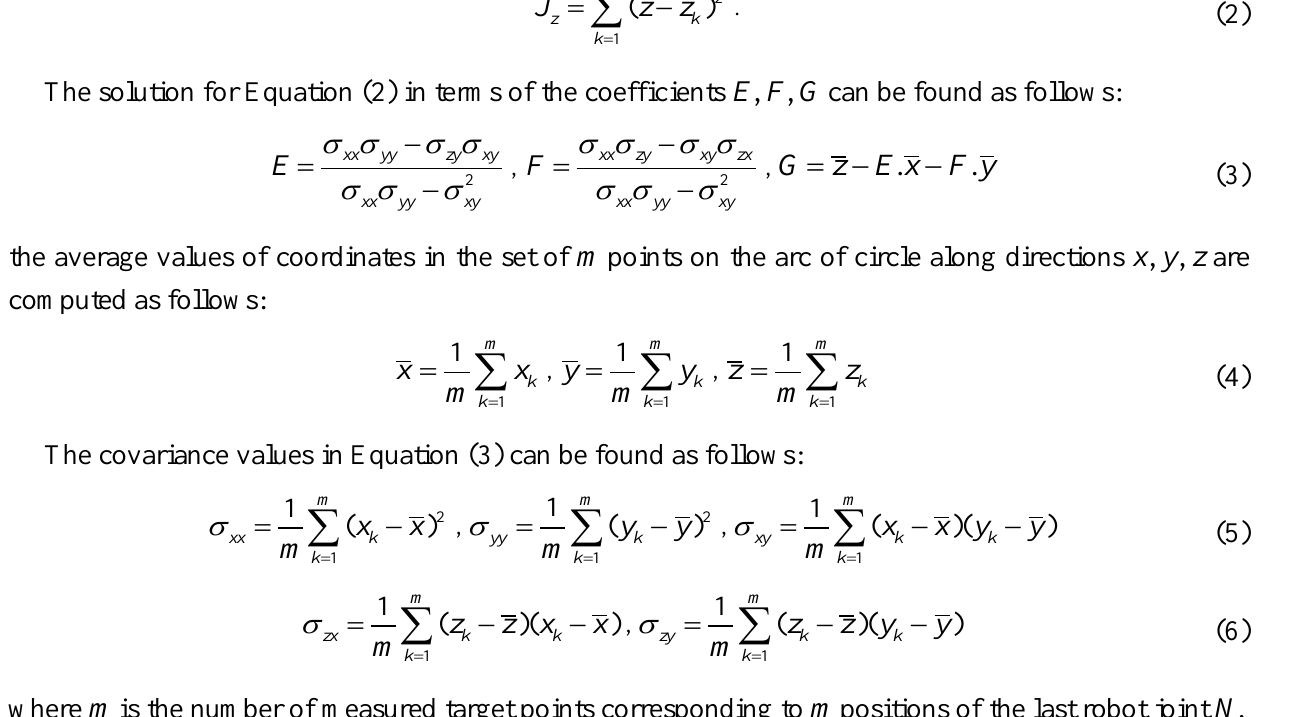
Figure 2. Point cloud transferring from frame Oxyz to frame O